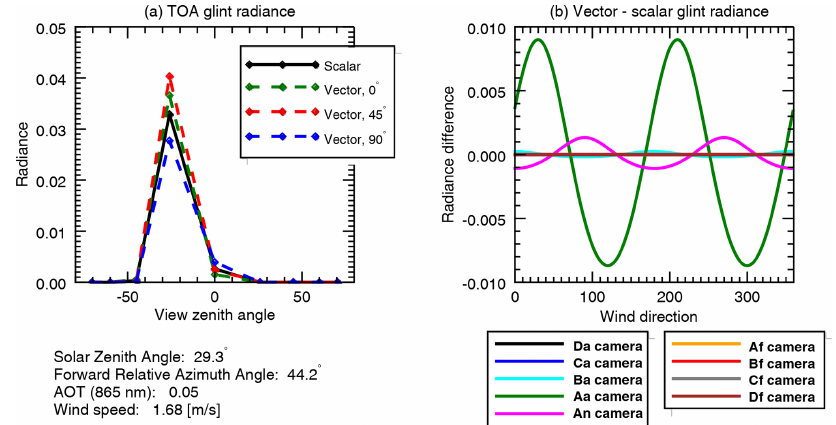
Figure 2. Differences between scalar (unidirectional) and vector (magnitude and direction) treatment of wind-influenced sun glint. Panel (a) represents the top-of-atmosphere (TOA) contribution to radiance due to ocean surface sun glint for a scene similar to test case A. The scalar parameterization is shown in black, while green, red, and blue dashed lines represent glint represented for the same wind speed (1.68ms − 1 ) but different headings. Panel (b) shows the scalar–vector difference in terms of TOA radiance for each MISR camera in the same scene, as a function of wind direction. Note that the Aa camera view, at 26 ◦ aft, is closest to the reflected sun glint peak at 29 . 3 ◦ and thus shows the largest impact of wind direction. These differences are used to create an uncertainty estimate, σ cm , that represents the potential error for scalar wind speed glint parameterization compared to that of the vector